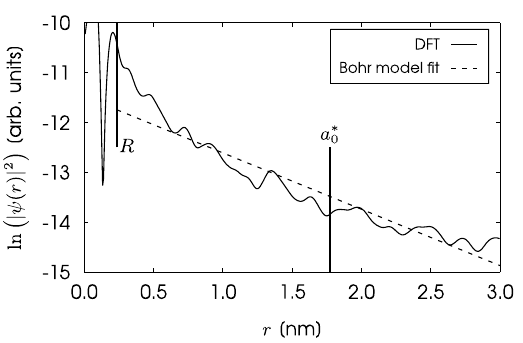
Figure 2. Natural logarithm of the spherically averaged probability density for the phosphorus donor electron ψ r [ln( ( ) )] 2 versus radial distance from the donor site [ r ] (solid line). A fit to this probability density described by the natural log of the square of the envelope function [ln ( F ( r ) 2 )] (dashed line). The model radius [ R ] and effective Bohr radius [ ⁎ a ] are also shown (vertical solid lines). The wavefunction of the donor electron has been 0 calculated using a supercell of 10,648